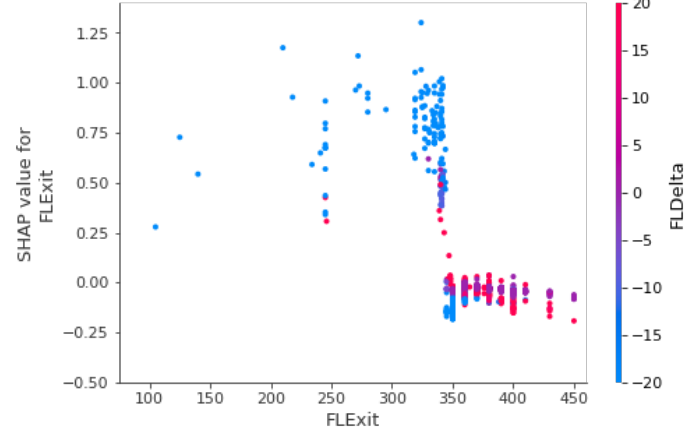
Figure 11. SHAP values (regression) of FLExit according to FLDelta for Sector 1.